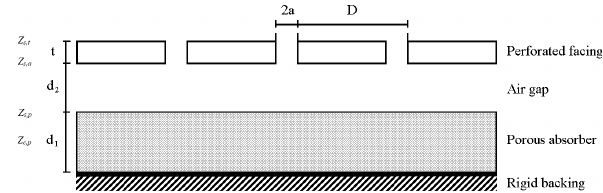
Figure 11: Sketch of the multilayer layout (adapted from